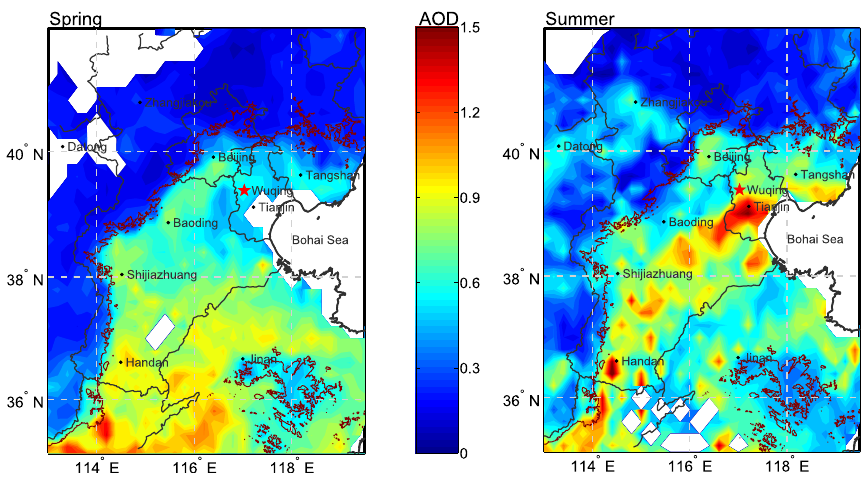
Fig. 1. The map of the NCP. The site is marked as a star. The shaded contour represents the distribution of the MODIS AOD. The dark red dashed denotes the 500m contour line, which also can be considered as the boundary of the